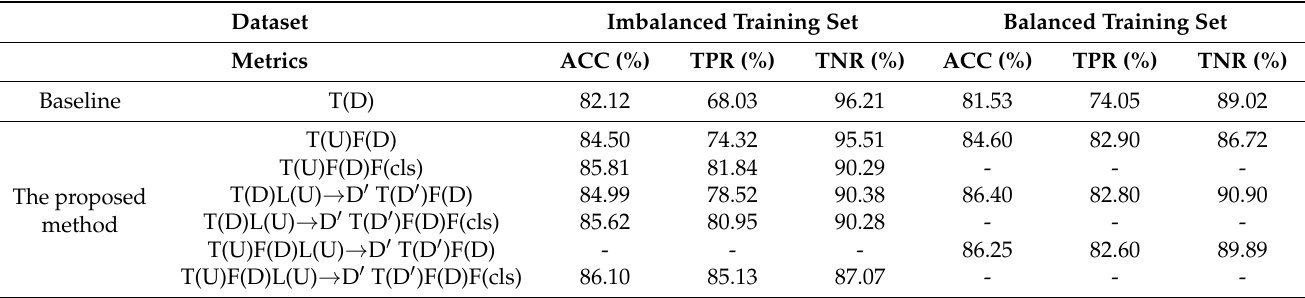
Table 4. Results of experiments performed with the proposed method (compared with the